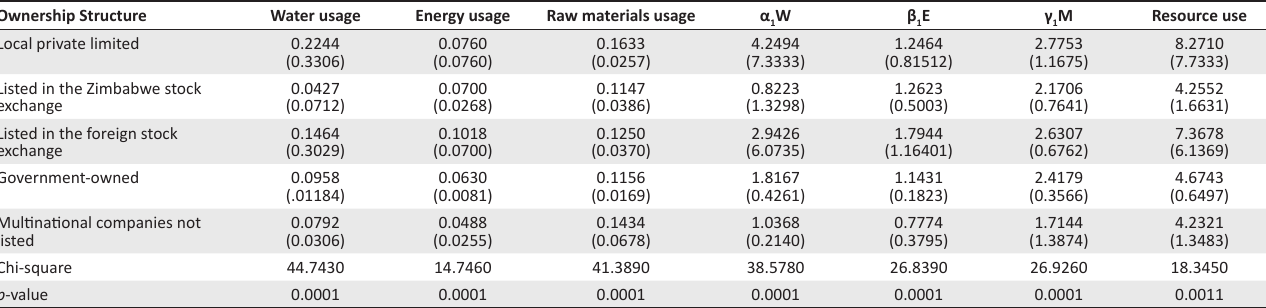
TABLE 2: Objective measures in resource use. Ownership